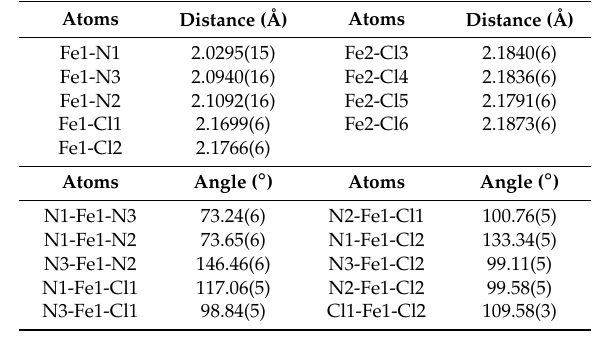
Table 2. Bond distances and angles in 1 .